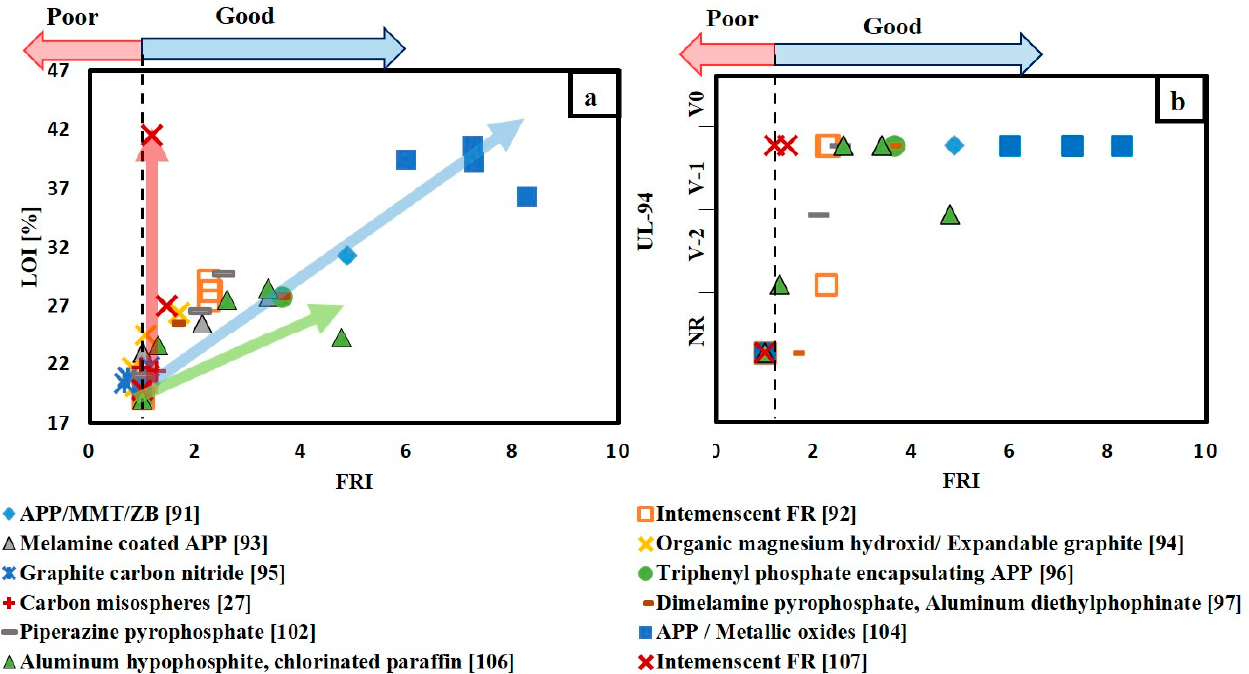
Figure 9. ( a ) FRI versus LOI for various FR/unsaturated polyester system; ( b ) FRI versus UL-94 for various FR/unsaturated polyester resin.